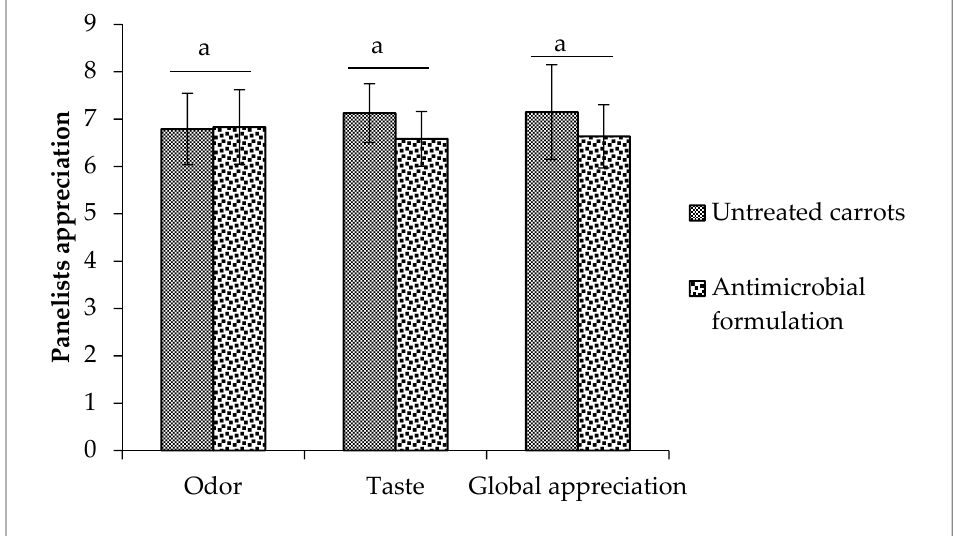
Figure 2. E ff ect of antimicrobial treatment on sensorial properties of pre-cut Figure 2. Effect of antimicrobial treatment on sensorial properties of pre-cut carrots.